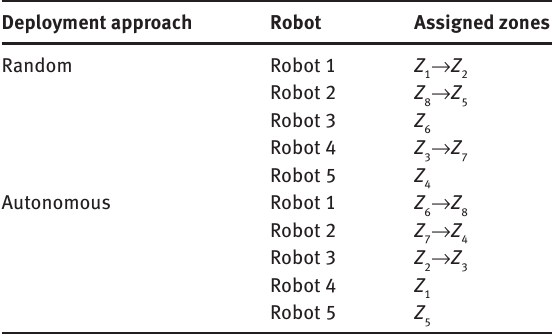
Table 6: Assigned Areas for the Scenario with Five Mobile Robots. Deployment